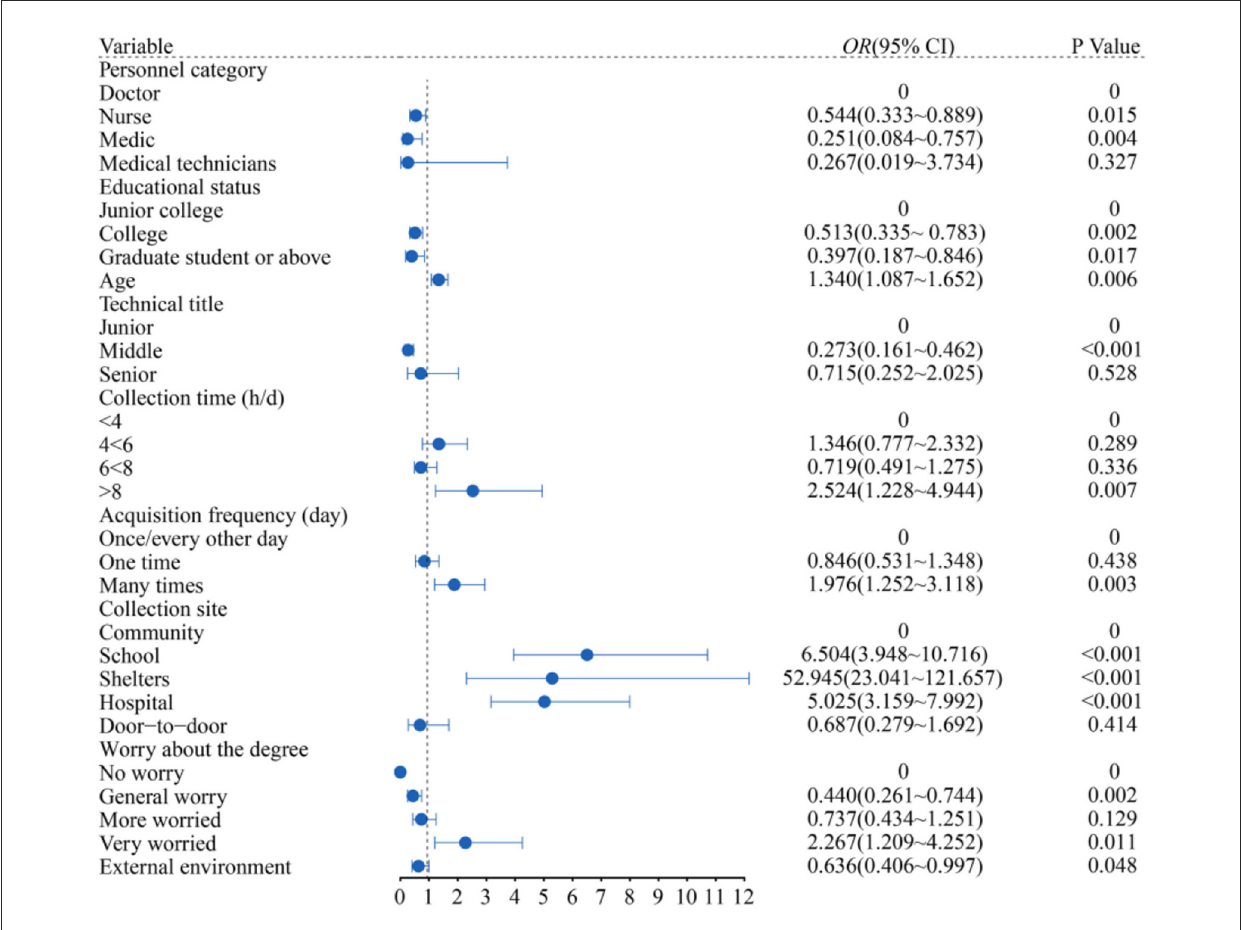
FIGURE2 Results of binary logistic model to predict anxiety